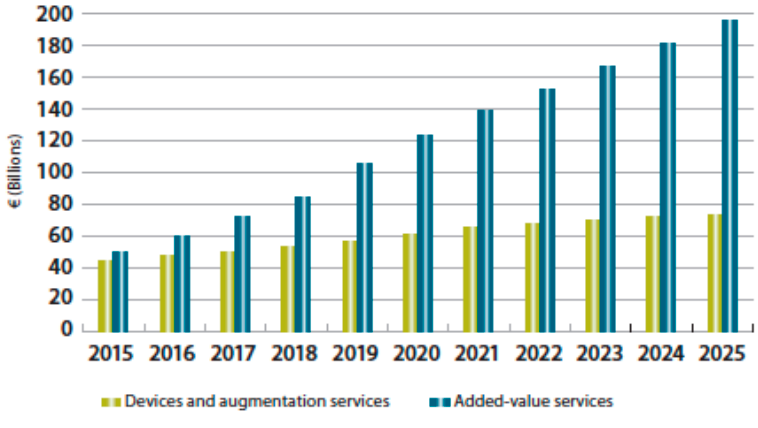
Figure 4. Revenue by type .